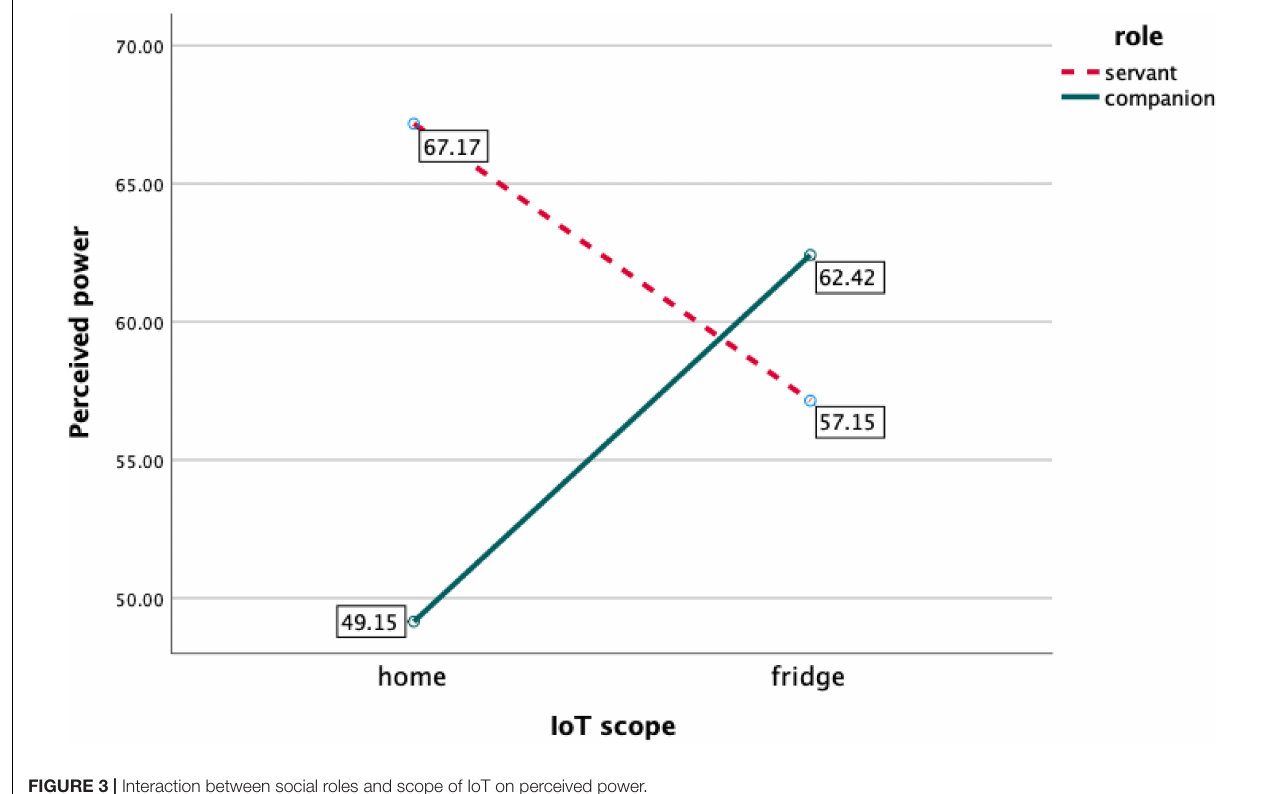
FIGURE 3 | Interaction between social roles and scope of IoT on perceived power.